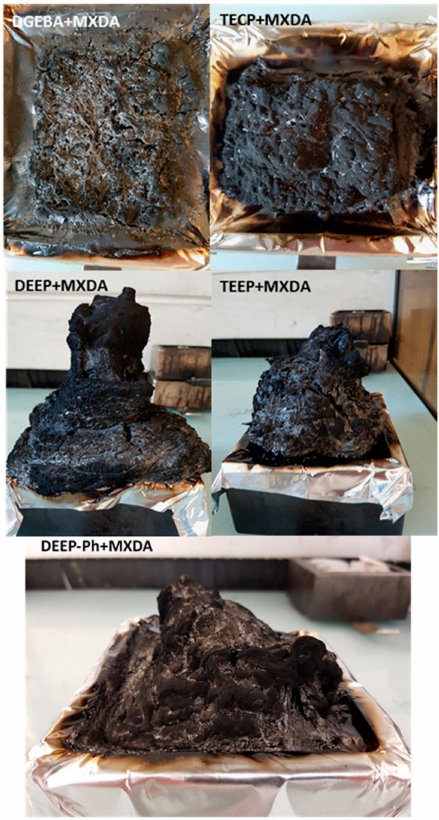
Figure 8. Pictures of residues from cone calorimeter